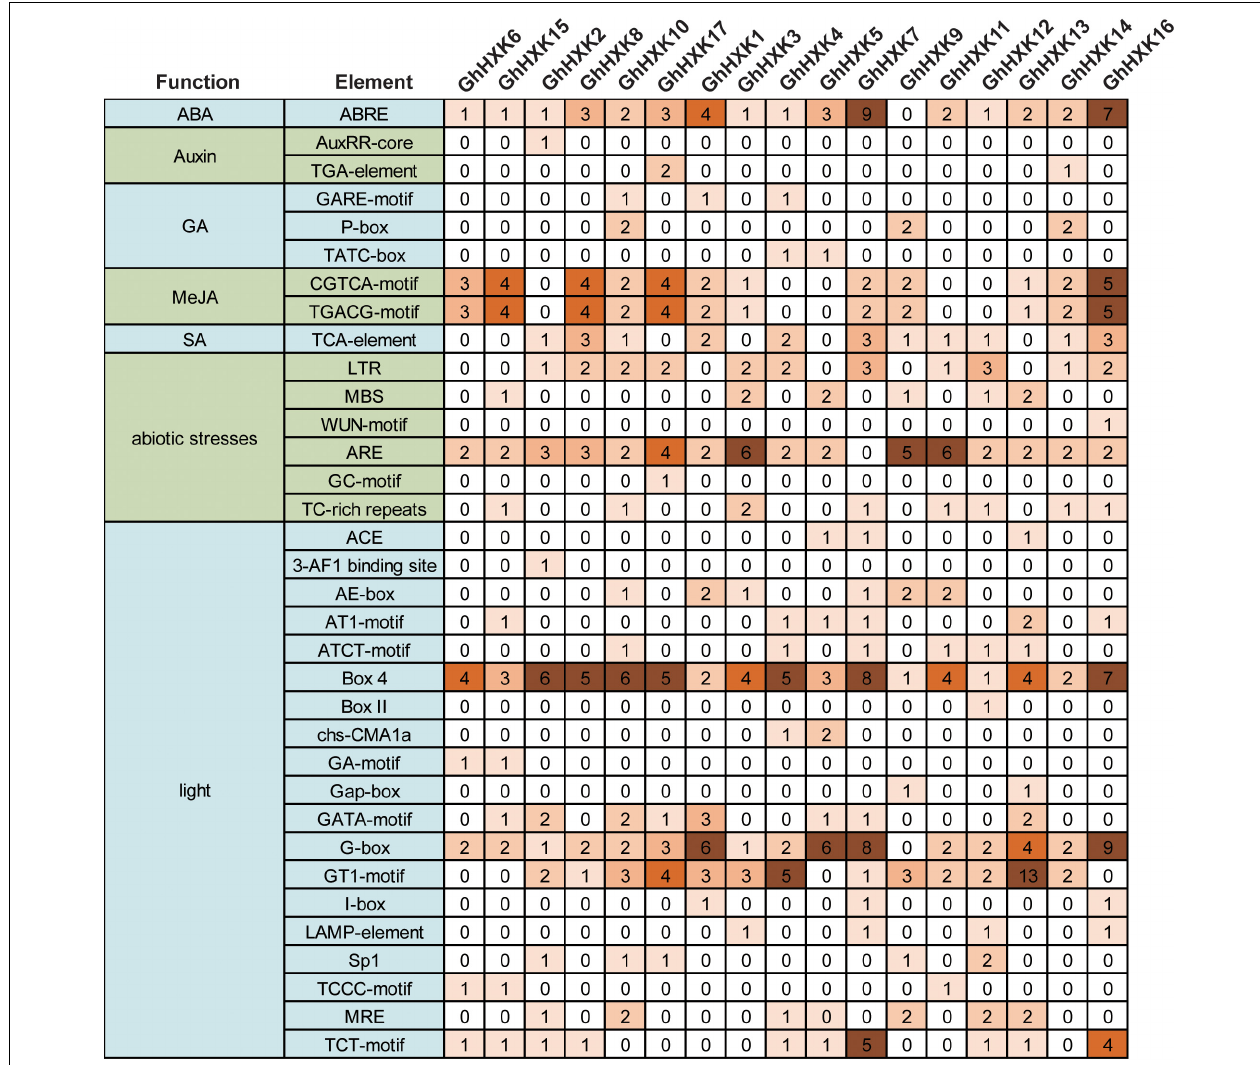
FIGURE 7 | Cis -elements in the promoters of GhHXK genes. Numbers in the box are the number of cis